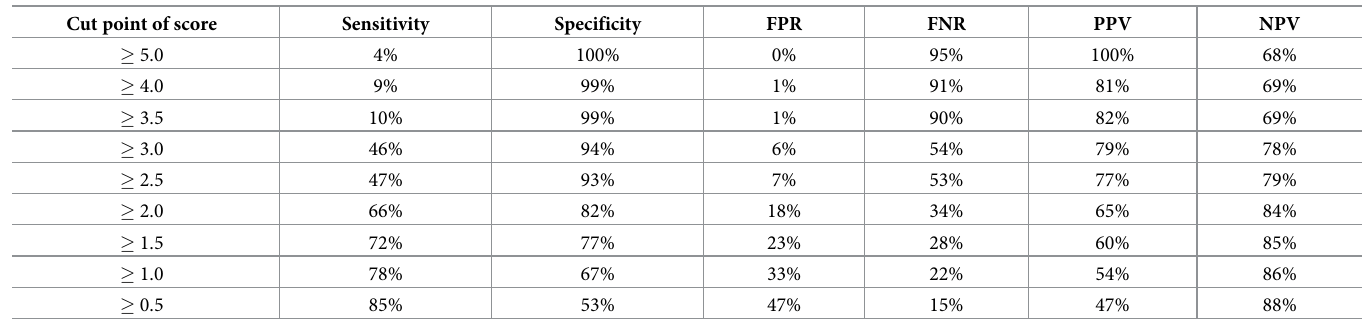
PAS—placenta accreta spectrum, PBL—perioperative blood loss, FPR—false positive rate, FNR—false negative rate, PPV—positive predictive value, NPV—negative predictive value